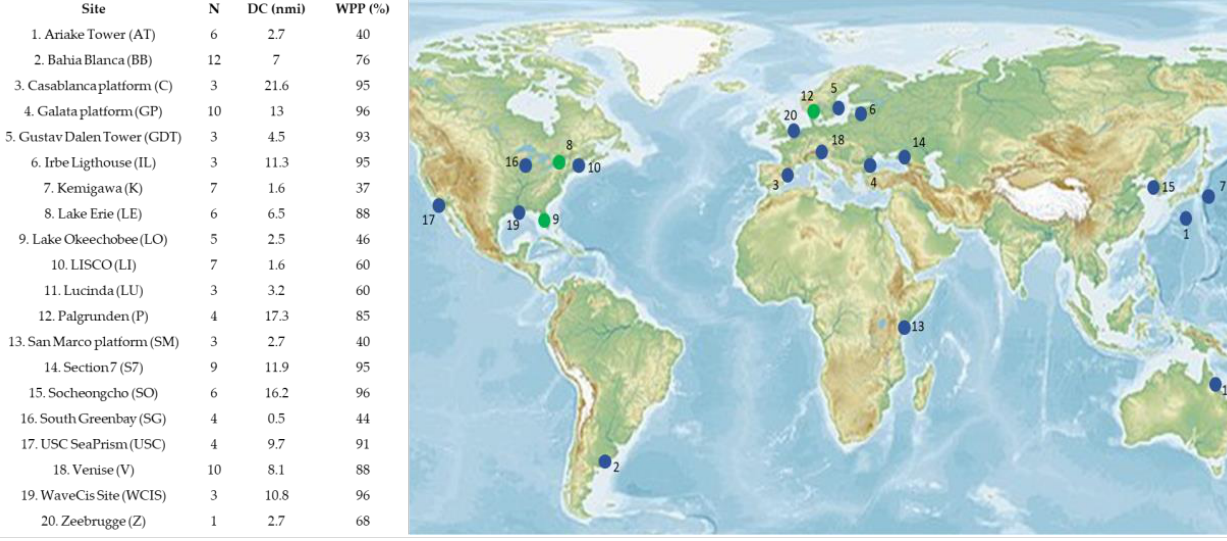
Figure 1. Global map showing the 20 AERONET-OC sites considered in the study for the validation of PRISMA L2d data (blue dots represent coastal water sites, and green dots represent freshwater sites). n represents the number of PRISMA images acquired for each site, DC represents the distance from the coastline (expressed in nautical miles (nmi)), and WPP represents the average percentage of water pixels present in the scene acquired by PRISMA for each site.